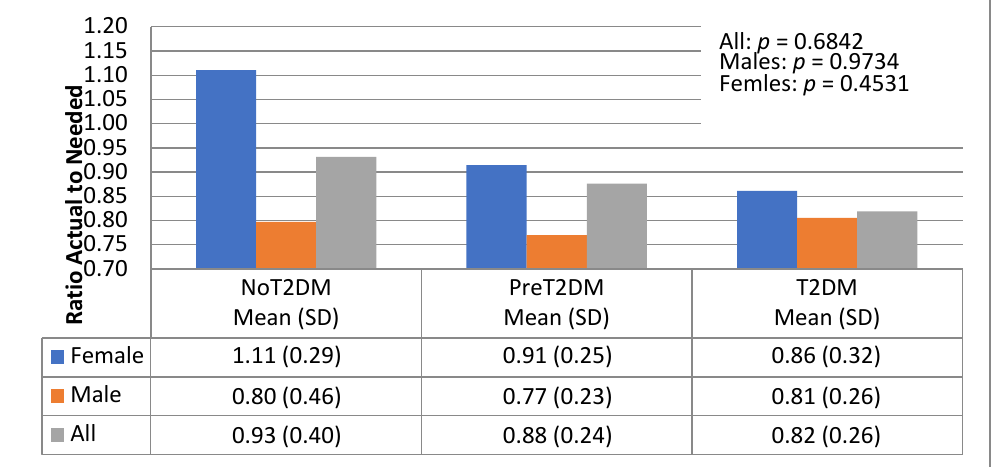
Figure 9. Actual to needed kilocalories from fat by diabetes status and gender. Correlational analysis also showed a significant relationship between diabetes sta- tus and actual to needed kilocalories from protein for females ( − 0.45, p = 0.0458).